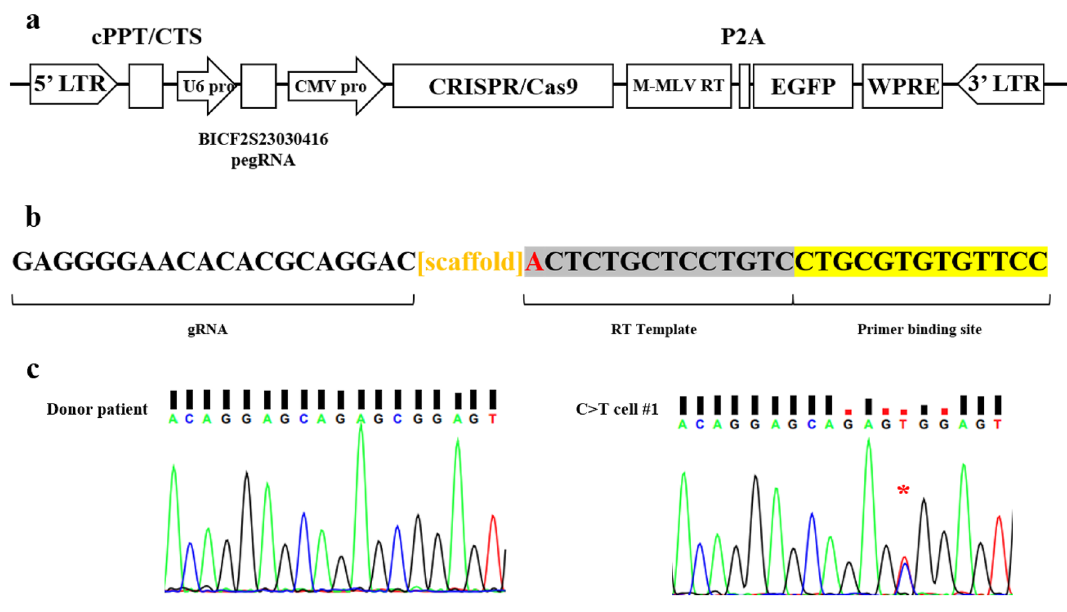
Figure 1. Correction of a point mutation in donor cells using prime editor (PE). ( a ) Schematic of PE vector. It consists of a prime editor that can correct SNP at the BICF2S23030416 locus and EGFP as a reporter. ( b ) Structure and design of PE guide RNA (pegRNA). The bracketed region in orange color indicates the scaffold for pegRNA 17 . The nucleotide (A) in red indicates the SNP mutation site. ( c ) Chromatographic analysis of the donor patient cells and C>T cell #1. The red asterisk indicates the target locus and confirms the C to T sequence correction mediated by